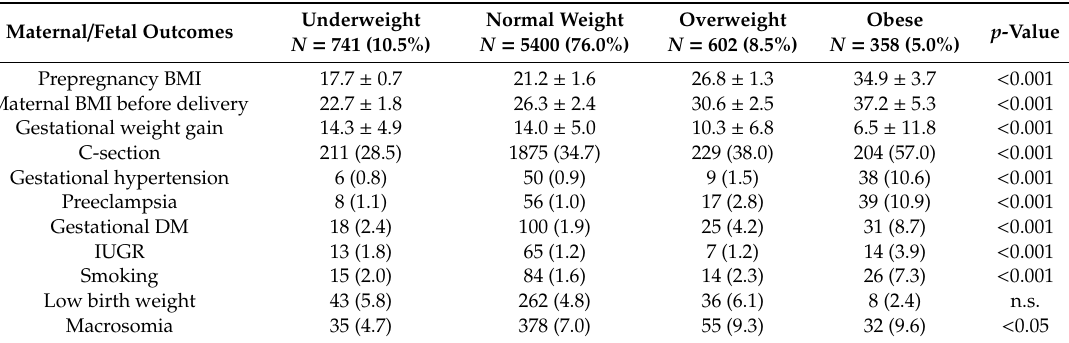
Table 1. Maternal / fetal outcomes among body mass index (BMI) categories in the sample of pregnant women ( N =